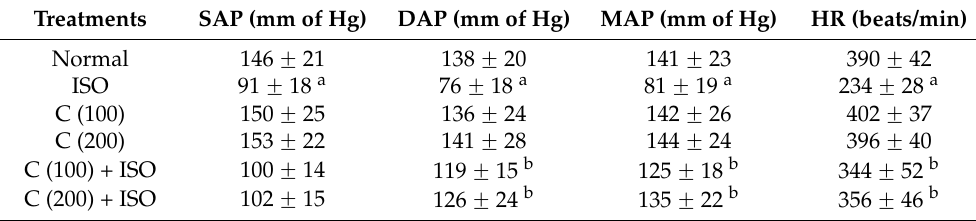
Table 1. Effect of cardamom on hemodynamic parameters in the isoproterenol-induced myocardial infarction in